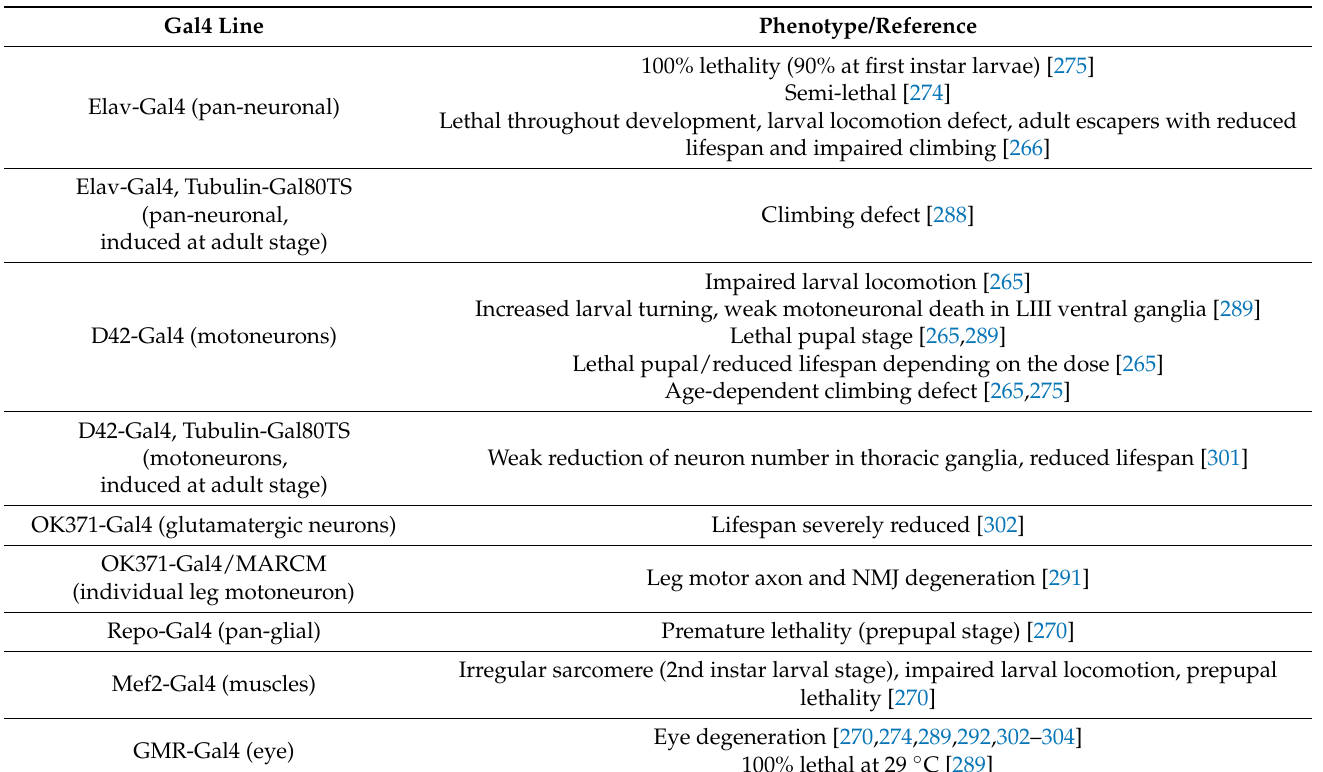
Table 9. Gain-of-function phenotypes induced by